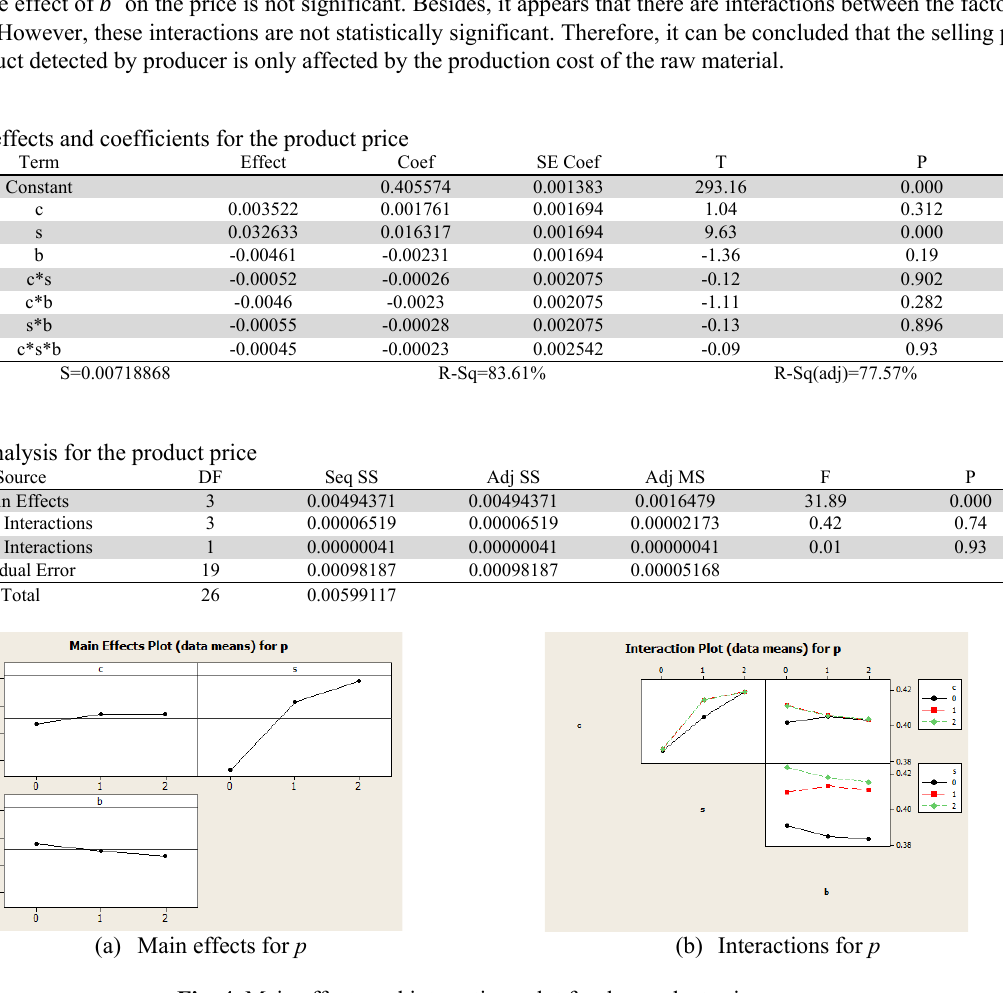
Fig. 4. Main effects and interactions plot for the product